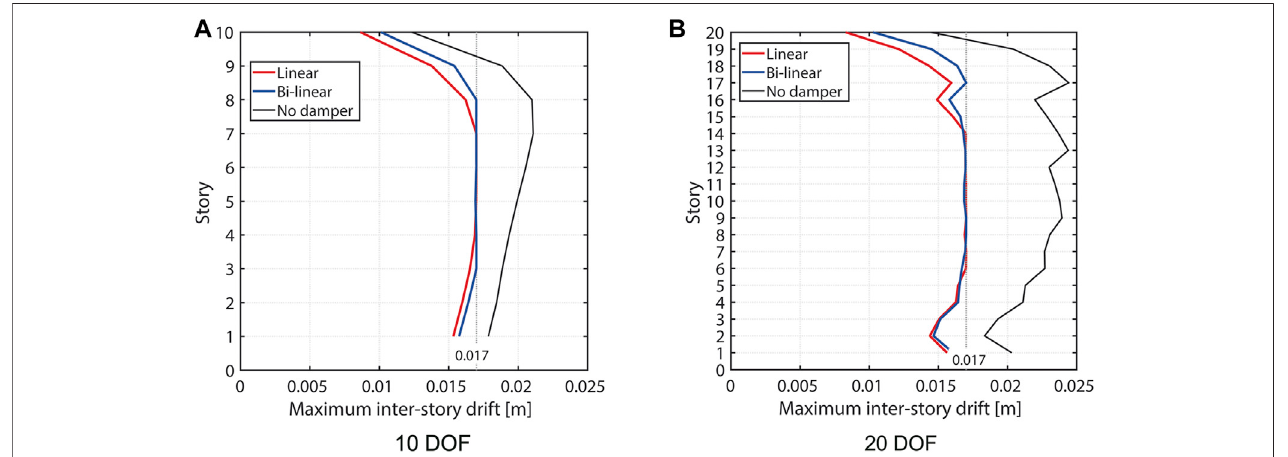
FIGURE 9 | Maximum interstory drift